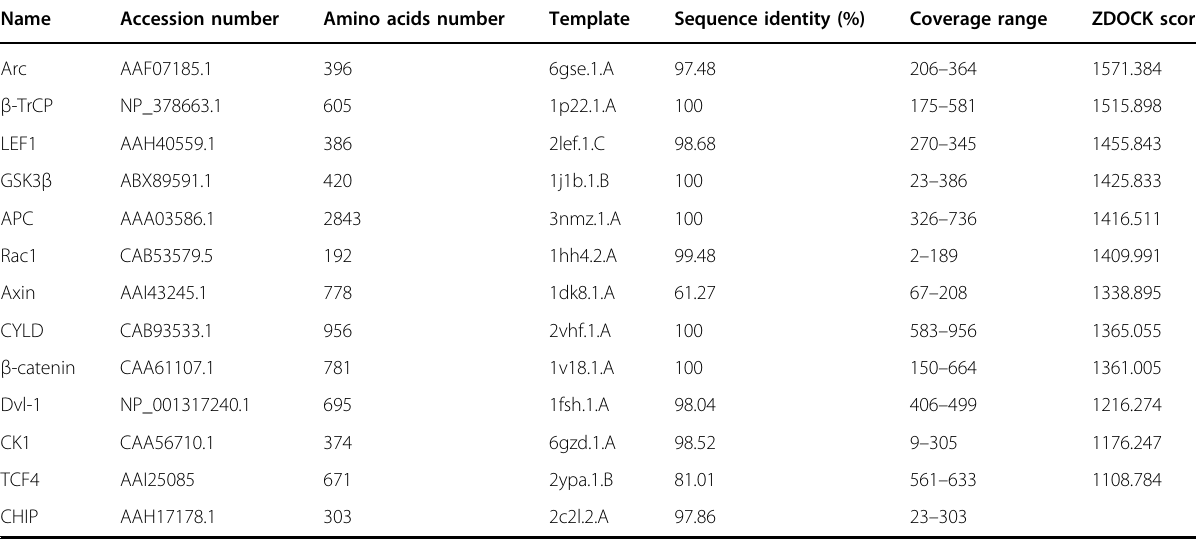
Table 1 The protein-protein interactions between CHIP and Arc or the downstream proteins of Wnt pathway were detected by ZDOCK